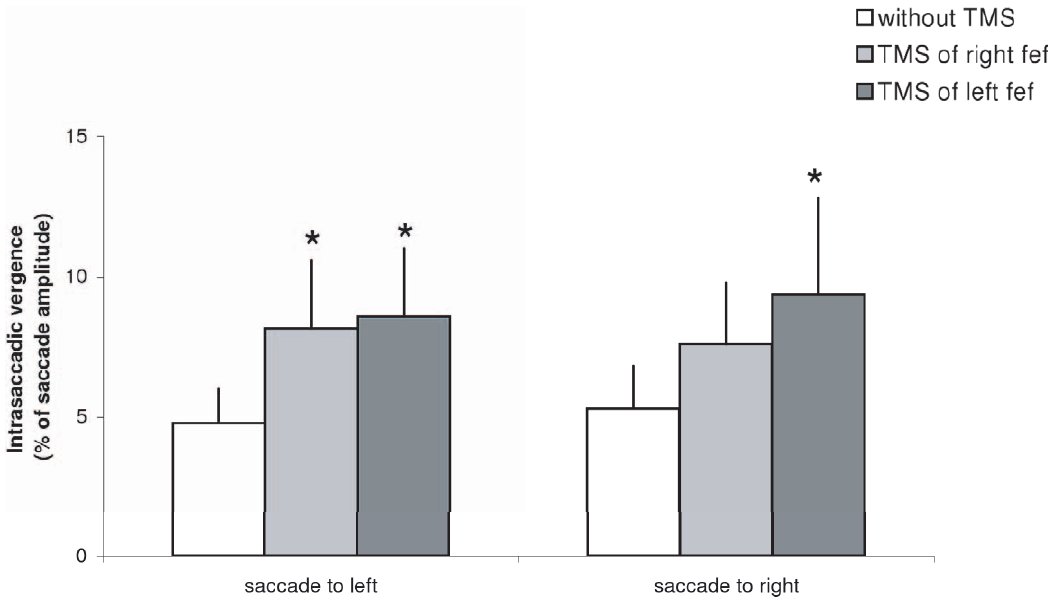
Figure 5. Mean values of intrasaccadic vergence with standard error. Asterisks indicate significant increases of intrasaccadic vergence after TMS of the left or the right FEF relative to no-TMS.